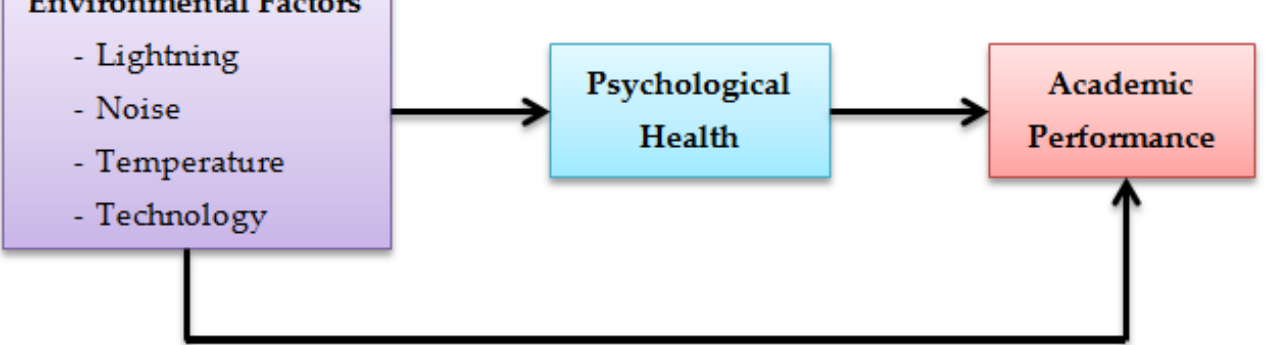
Figure 1. Hypothesized model of constructs.